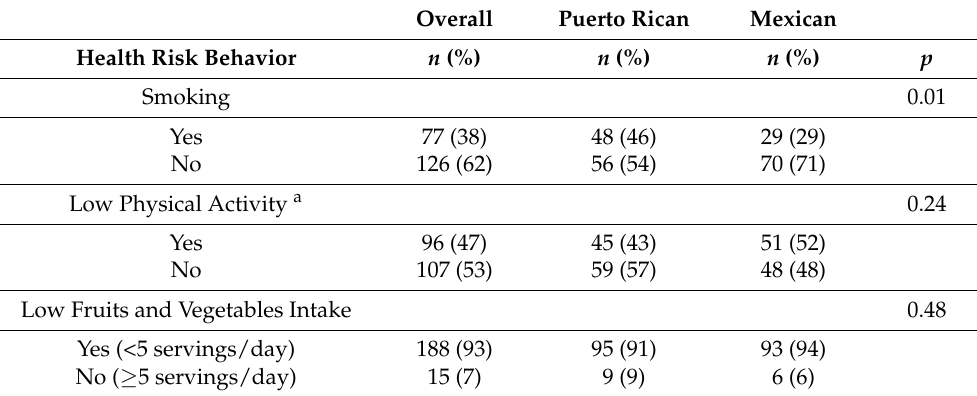
Table 2. Prevalence of health risk behaviors among Latino men ( n =